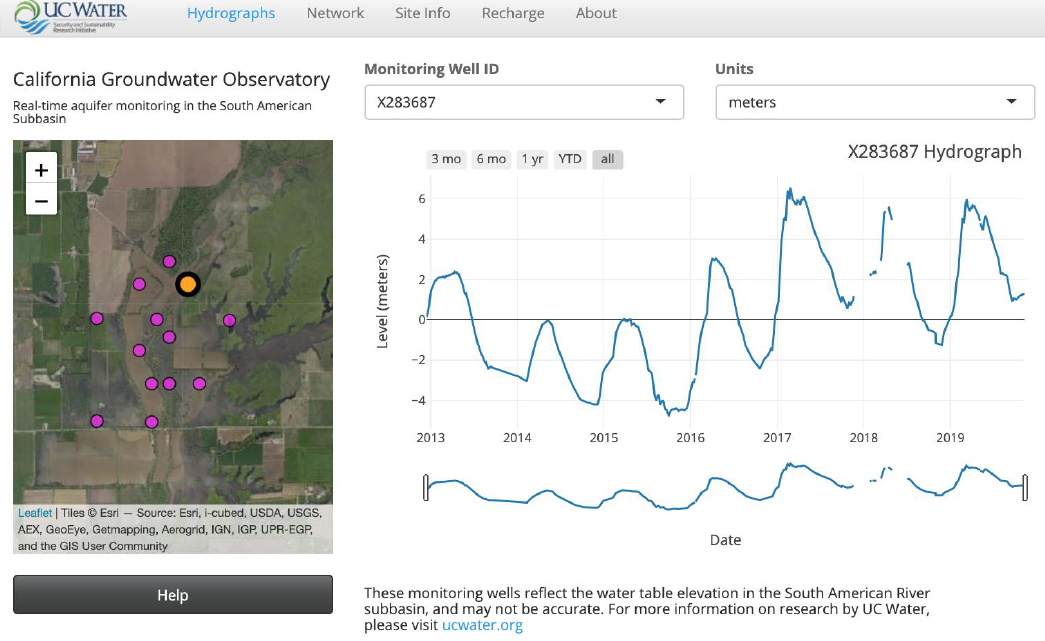
Figure 4. Main page of the online dashboard for the GWO. A single monitoring well is selected (yellow dot) from all wells (pink) on the map (left), and the selected well’s hydrograph is displayed (right).